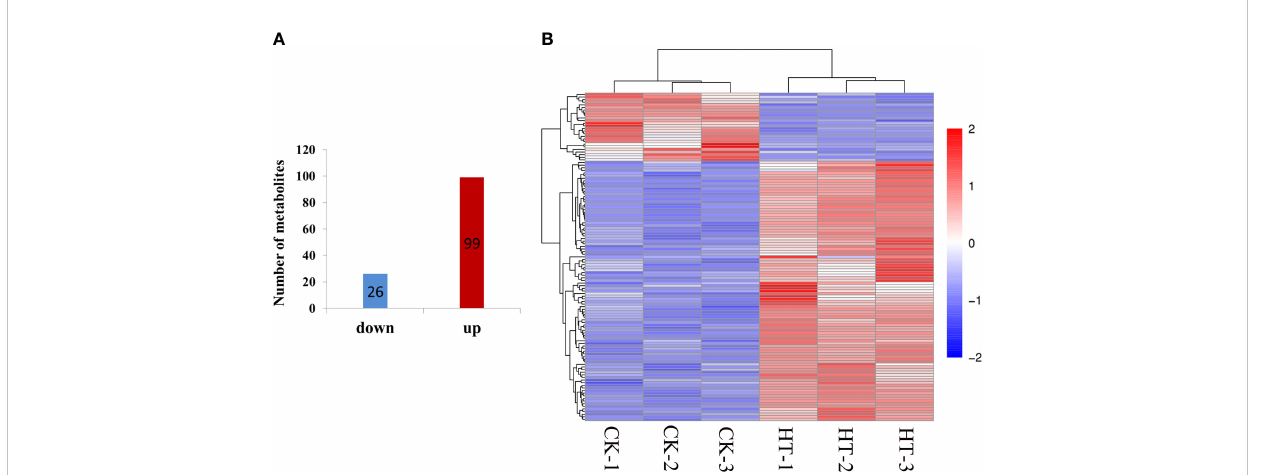
FIGURE 3 Differential metabolites in high-temperature stress compared with the normal condition at mature anther stages. (A) Number of up- and downregulated metabolites in high-temperature stress compared with normal condition. (B) Expression patterns of differential metabolites in high- temperature stress compared with normal